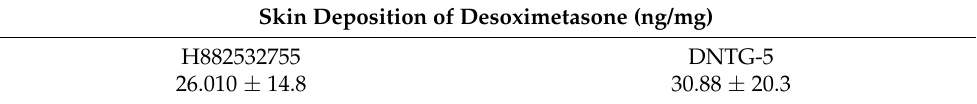
Table 11. Amount of desoximetasone detected in human cadaver skin ( n = 6, mean ±